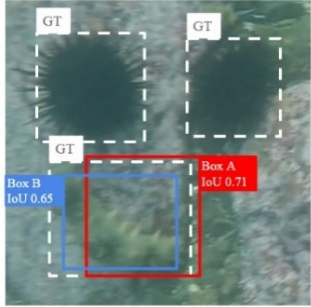
Figure 5. Example of IoU.